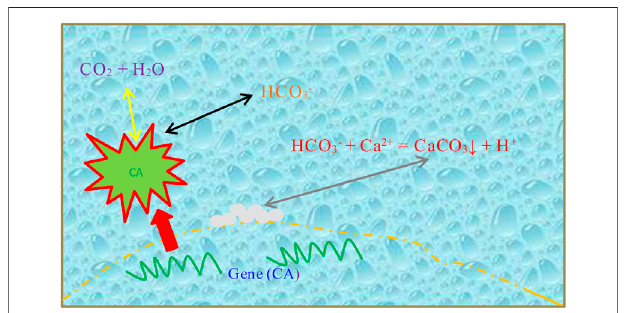
FIGURE 1 | Microbial carbonization of calcium carbonate using Streptomyces micro fl avus